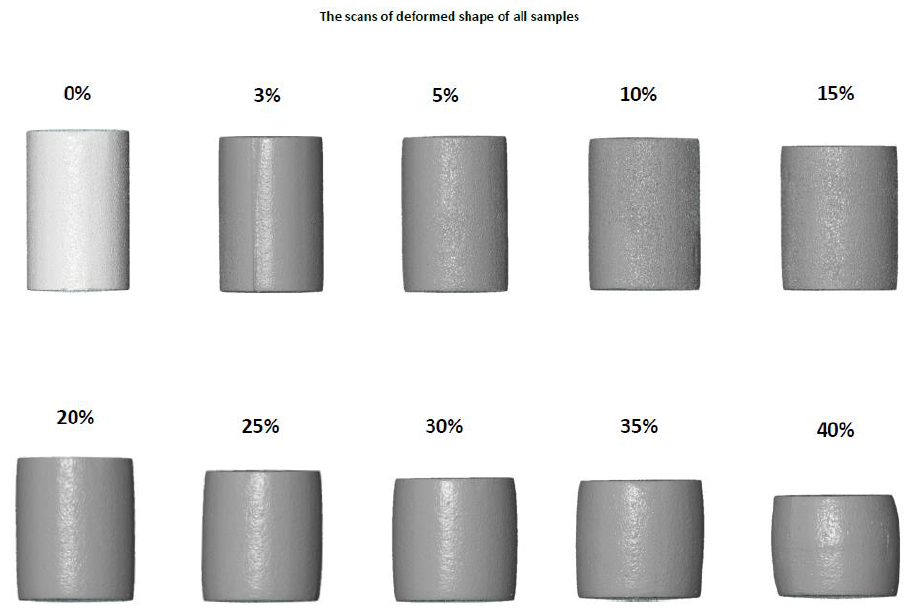
Figure A2. Cross section and outer contours of all samples after deformation.